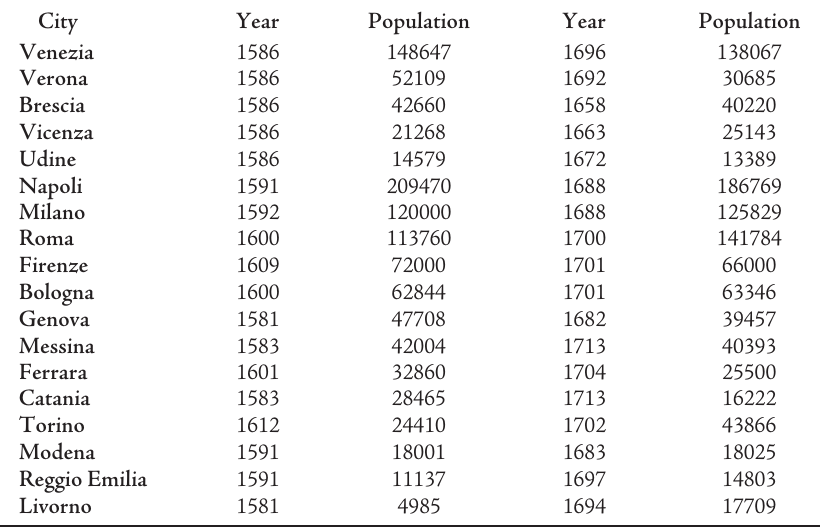
Table 1 – Population of Some Italian Cities at the End of the 16 th and 17 th